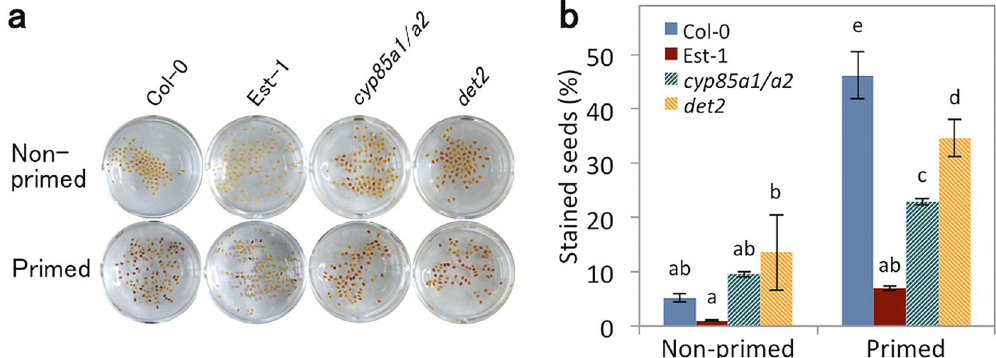
Figure 7. Changes in seed coat permeability after priming. ( a ) Tetrazolium staining of wild type Col-0 (Col-0), Est-1, cyp85a1 cyp85a2 ( cyp85a1 / a2 ) and det2 seeds before (non-primed) and after (primed) priming. ( b ) Numbers of stained seeds (red colored seeds) before (non-primed) and after (primed) priming for Col-0, Est-1, cyp85a1 / a2 and det2 . Values presented are means ± SD of three replicates. Different letters indicate significant differences (P < 0.05, Tukey-Kramer